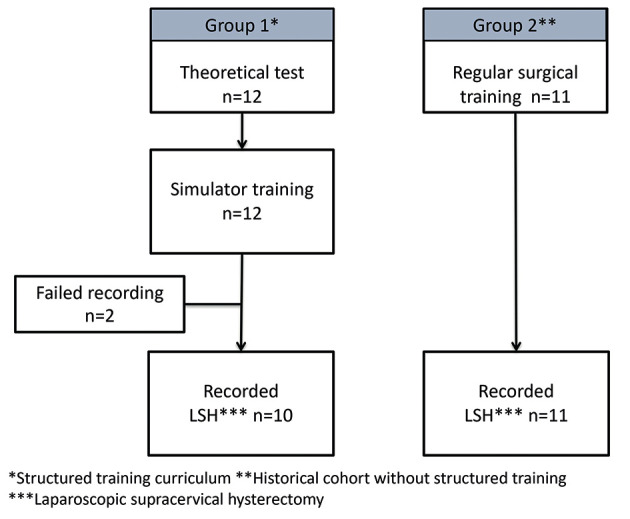
— Study flow chart.